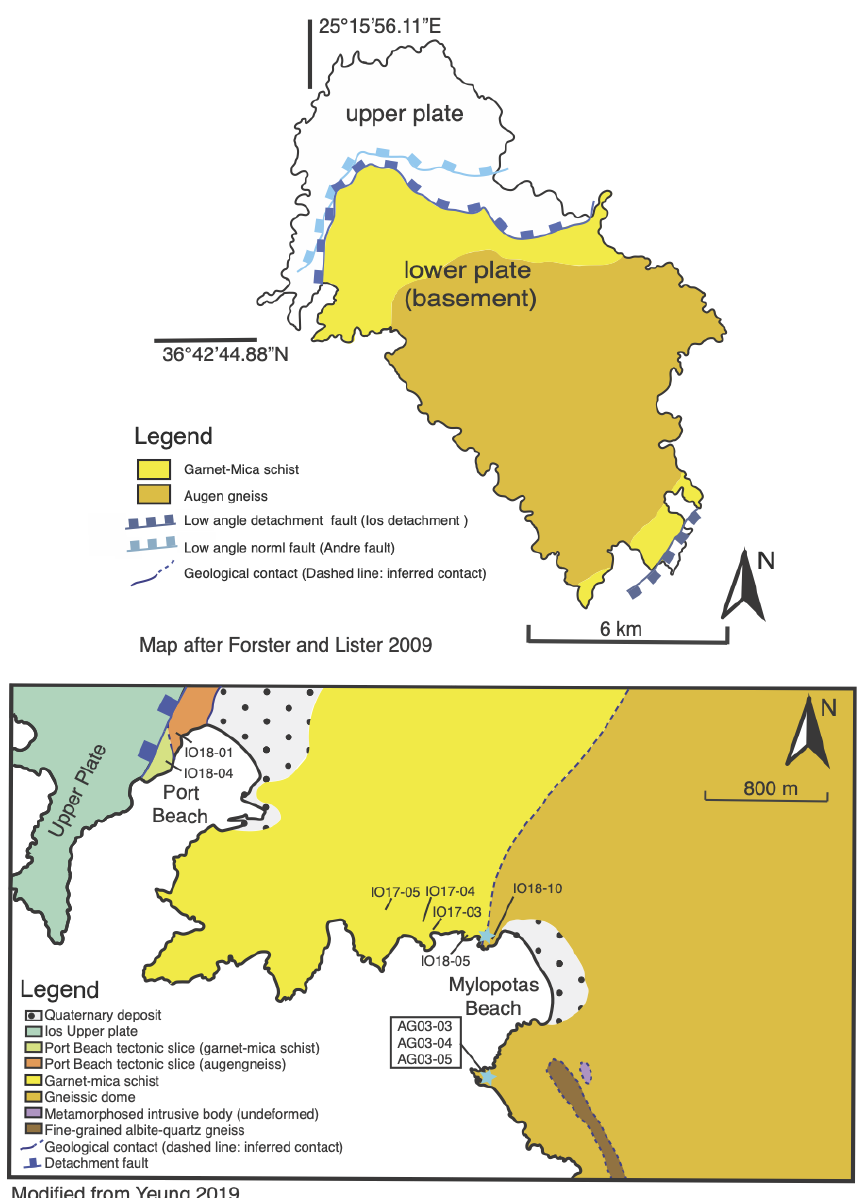
Figure 4. Top: island-scale map illustrating major lithologies. Bottom: Detailed map of study area with sample collection sites, the entire area is affected by the broad, south-directed South Cyclades Shear Zone (SCSZ). Locations observed with overprinting narrow, north-directed shear zones are indicated by blue stars, diagrams after Yeung (2019). Detailed structural maps of areas marked with blue stars are in the